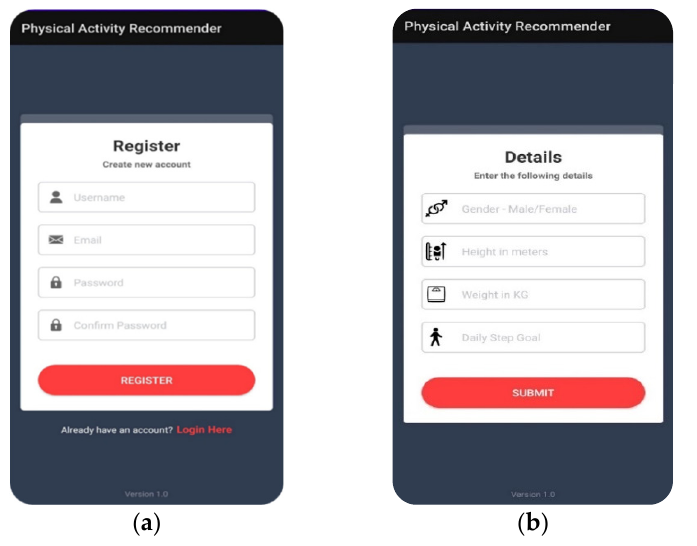
Figure 10. Recommended activity pattern and step count progress tracker: ( a ) register page of the android application; ( b ) user detail collection page.